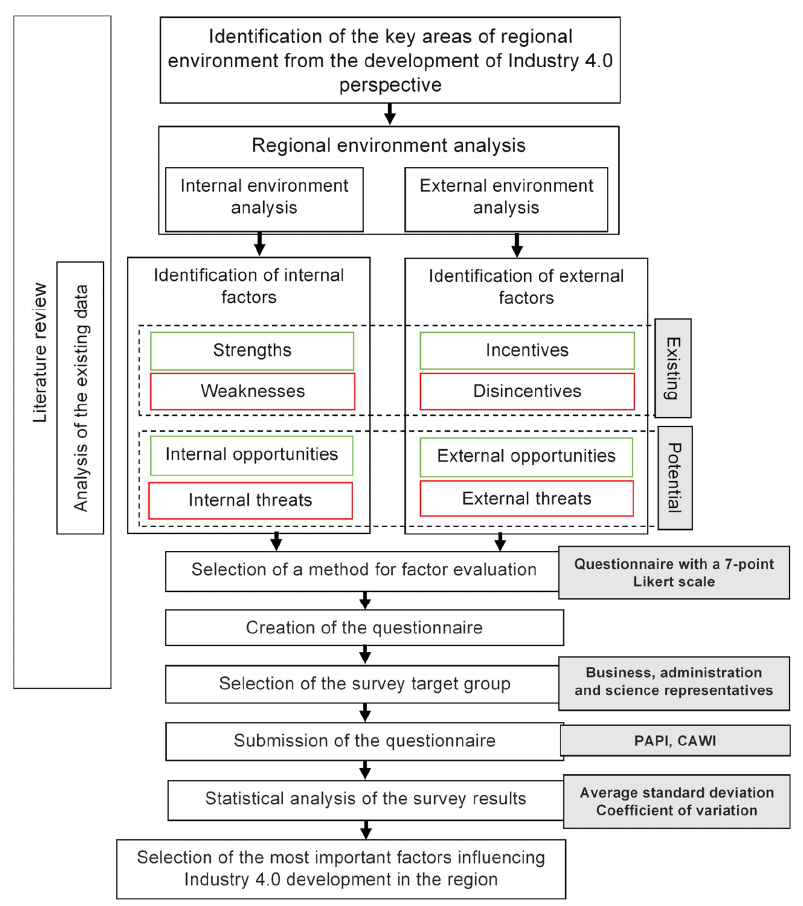
Figure 4. Research methodology implemented in the project.